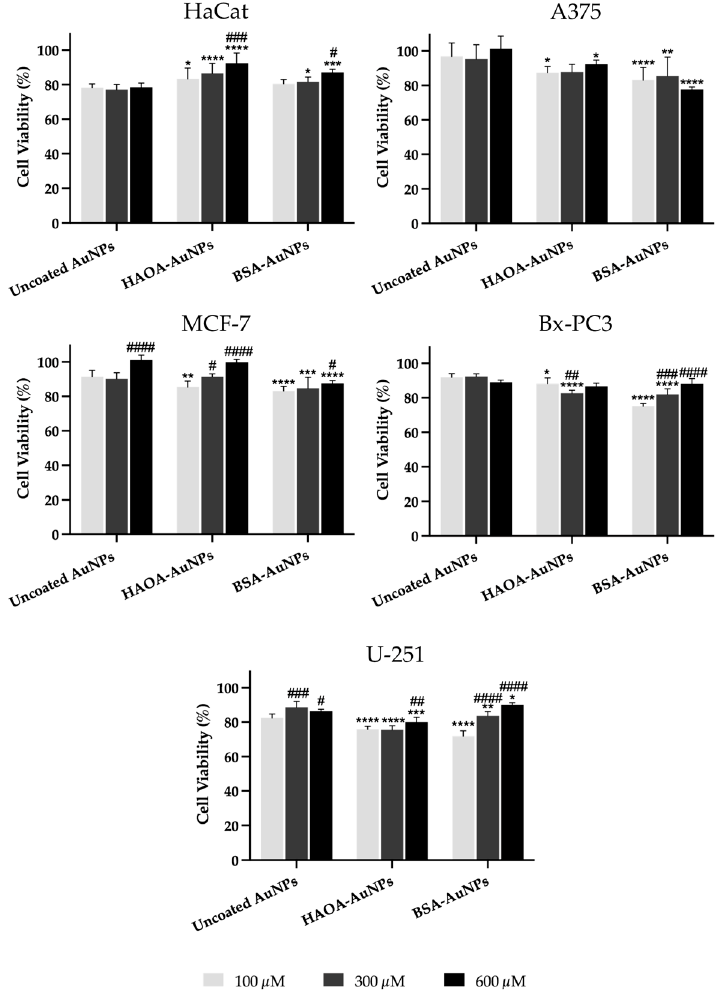
Figure 4. Cell viability (%) of HaCat, A375, MCF-7, Bx-PC3 and U251 cell lines 24 h after incubation with uncoated AuNPs, HAOA-AuNPs and BSA-AuNPs at three di ff erent concentrations (100, 300 and 600 µM). Data are presented as mean value ± SD, n ≥ 5. Two-way analysis of variance (ANOVA), Dunne tt ’s test ( p < 0.05), were used to detect di ff erences between the groups. * p < 0.0332, ** p < 0.0021, *** p < 0.0002 and **** p < 0.0001 vs. uncoated AuNPs at same concentration; # p < 0.0332, ## p < 0.0021, ### p < 0.0002 and #### p < 0.0001 vs. the respective formulation at 100 µM.